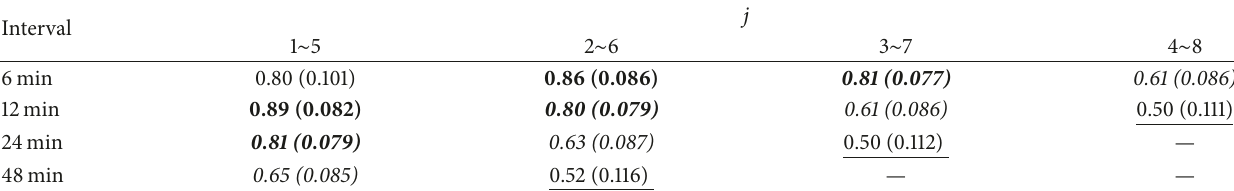
Table 5: Multiscales and multisampling for H of Site 2 (data length = 152307).